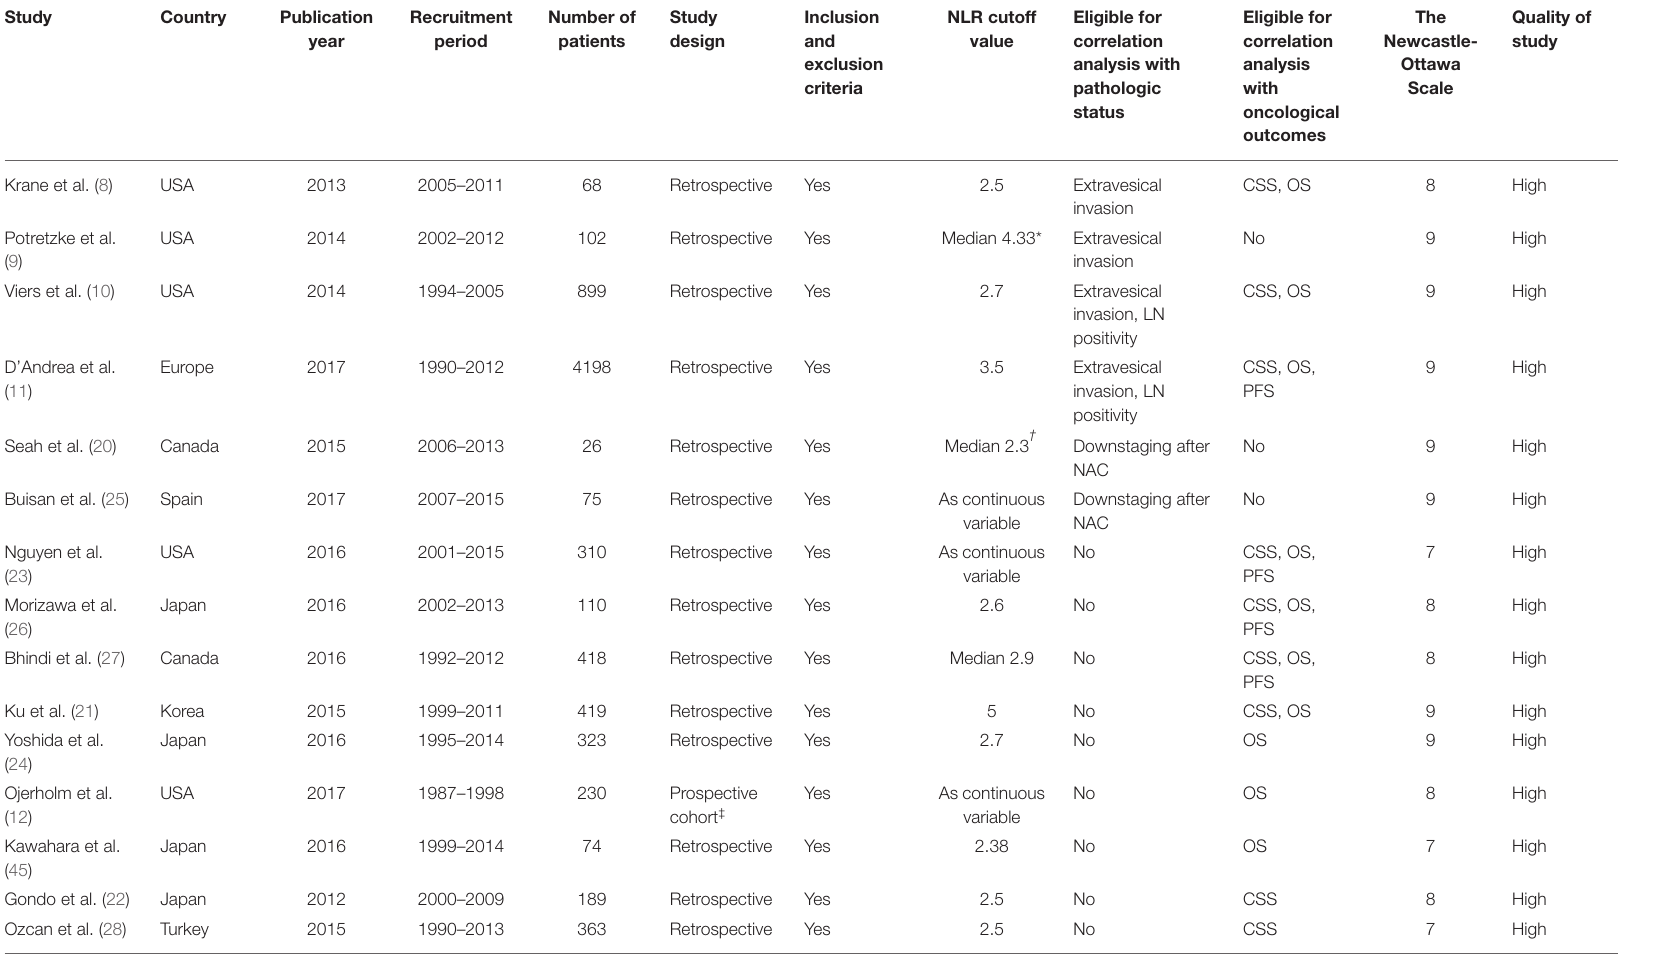
TABLE 2 | Characteristics of studies eligible for radical cystectomy